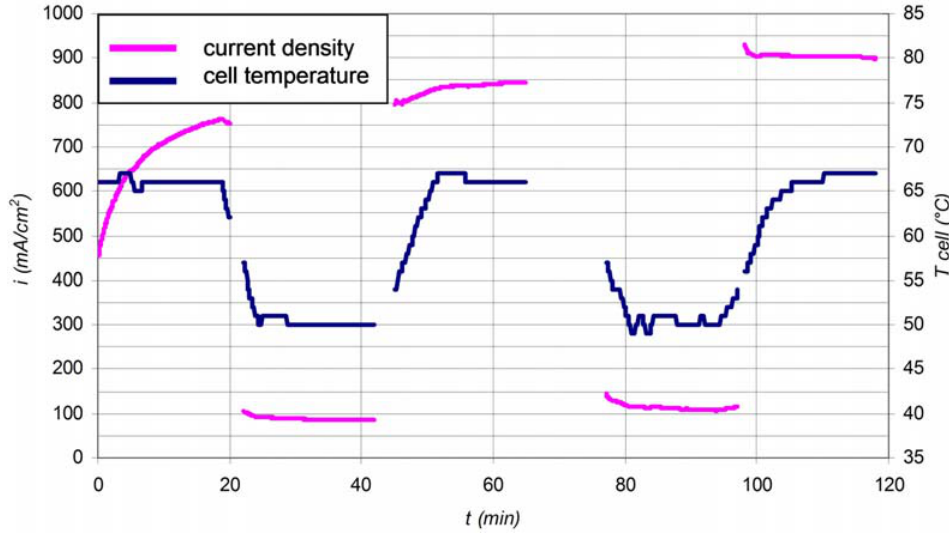
Fig. 1. Initial conditioning by temperature and potential cycling